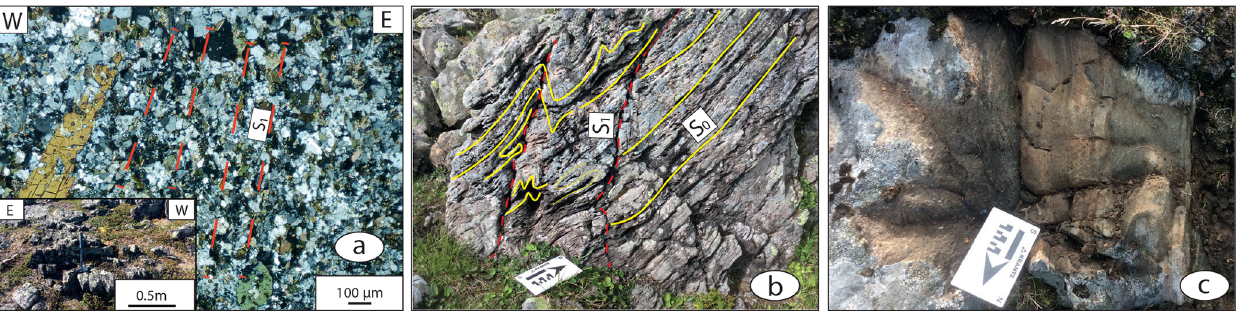
Figure 7. Characteristics of the Eustiljåkk key area. (a) Low-intensity S 1 foliation, X688743 Y7542711. (b) Parasitic F 1 folding of sedimen- tary horizons, X687043 Y7539378. (c) Scapolite-altered mafic dyke associated with N–S-directed high-strain zones, X687505 Y7543037. Coordinates: